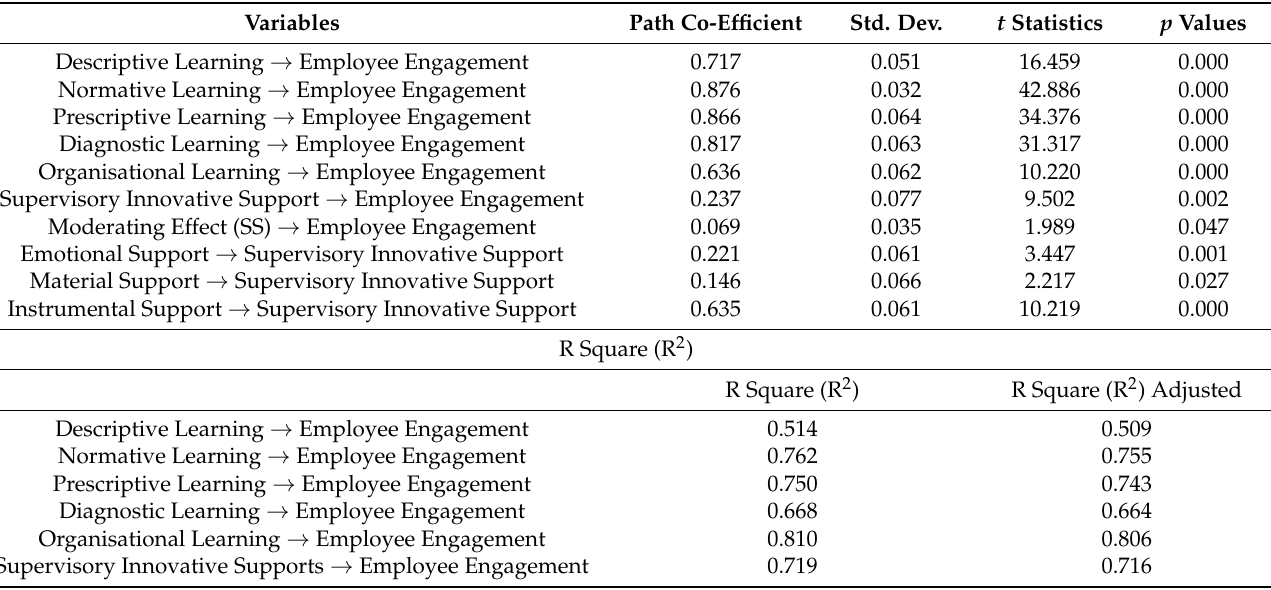
Table 1. Path coefficients for organisational learning, supervisory innovative support and employee